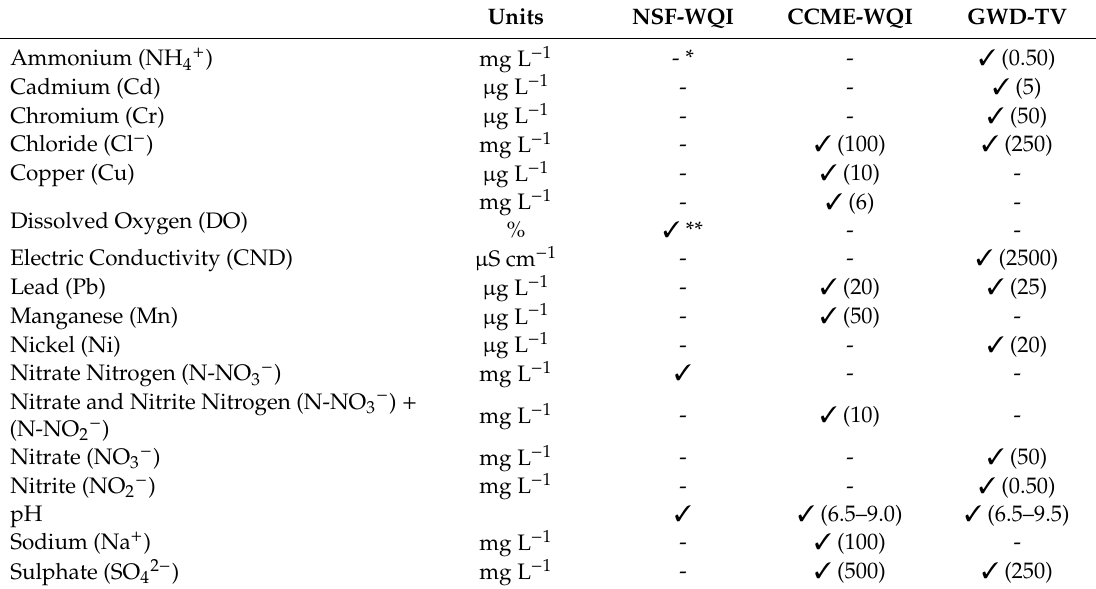
Table 1. Selected parameters for the classification of groundwater